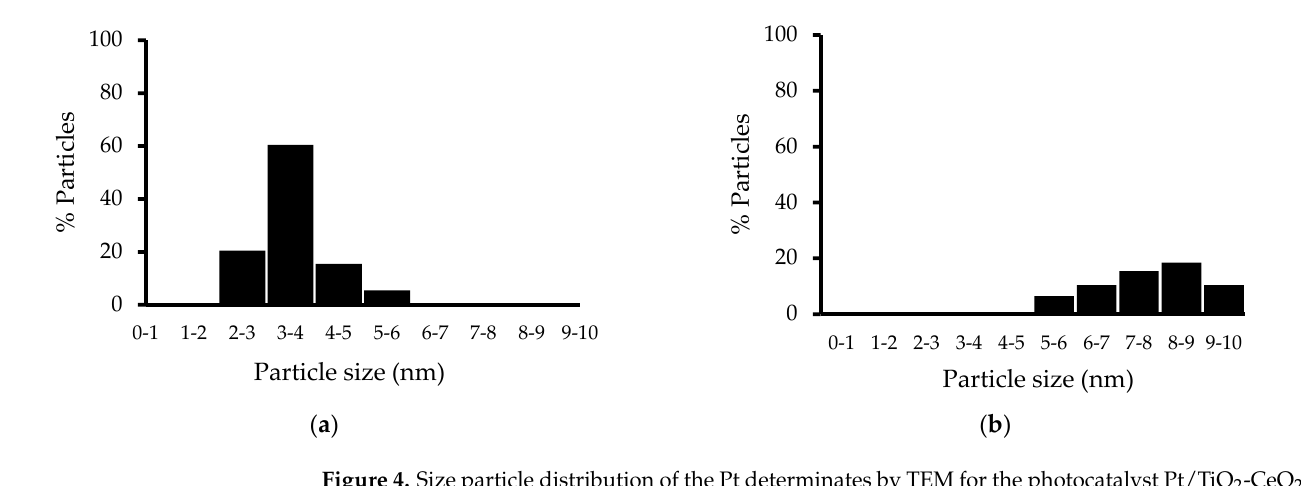
Figure 4. Size particle distribution of the Pt determinates by TEM for the photocatalyst Pt/TiO 2 -CeO 2 10 wt% ( a ) Sol-gel and ( b ) Impregnation.